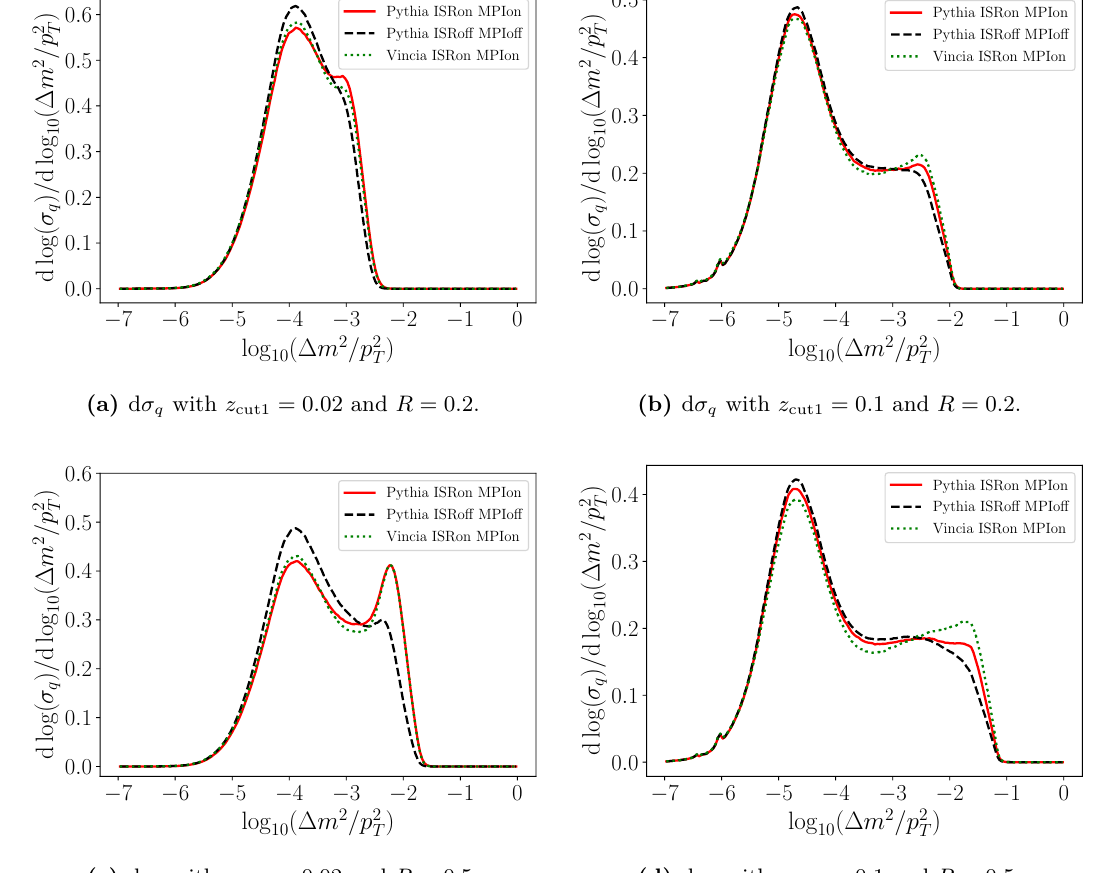
Figure 4. Monte Carlo results of the differential jet mass cross sections of quark jets in collinear drop, with β 1 = β 2 = 0 . The top panels have R = 0 . 2 and the bottom panels have R = 0 . 5 , while the left panels have z cut1 = 0 . 02 and the right panels have z cut1 = 0 . 1 . The red solid and green dotted lines include ISR and MPI effects and are results from Pythia and Vincia , respectively. The black dashed line is the Pythia result without ISR and MPI